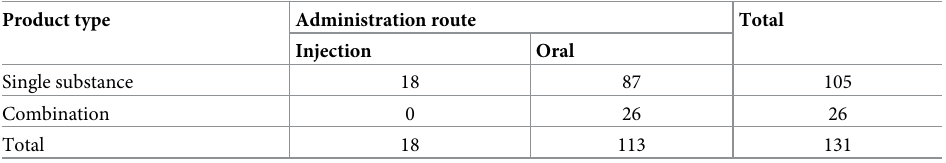
Table 3. Distribution of the antimicrobial products approved for use in poultry in Japan by administration route and the number of active ingredients